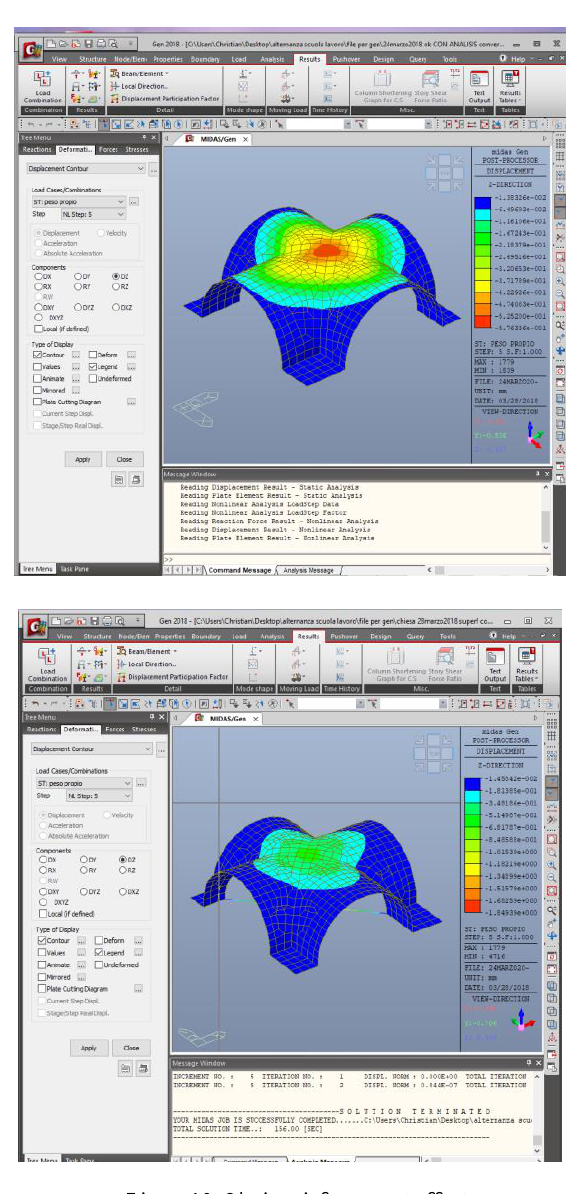
Figure 10. Chain reinforcement effects